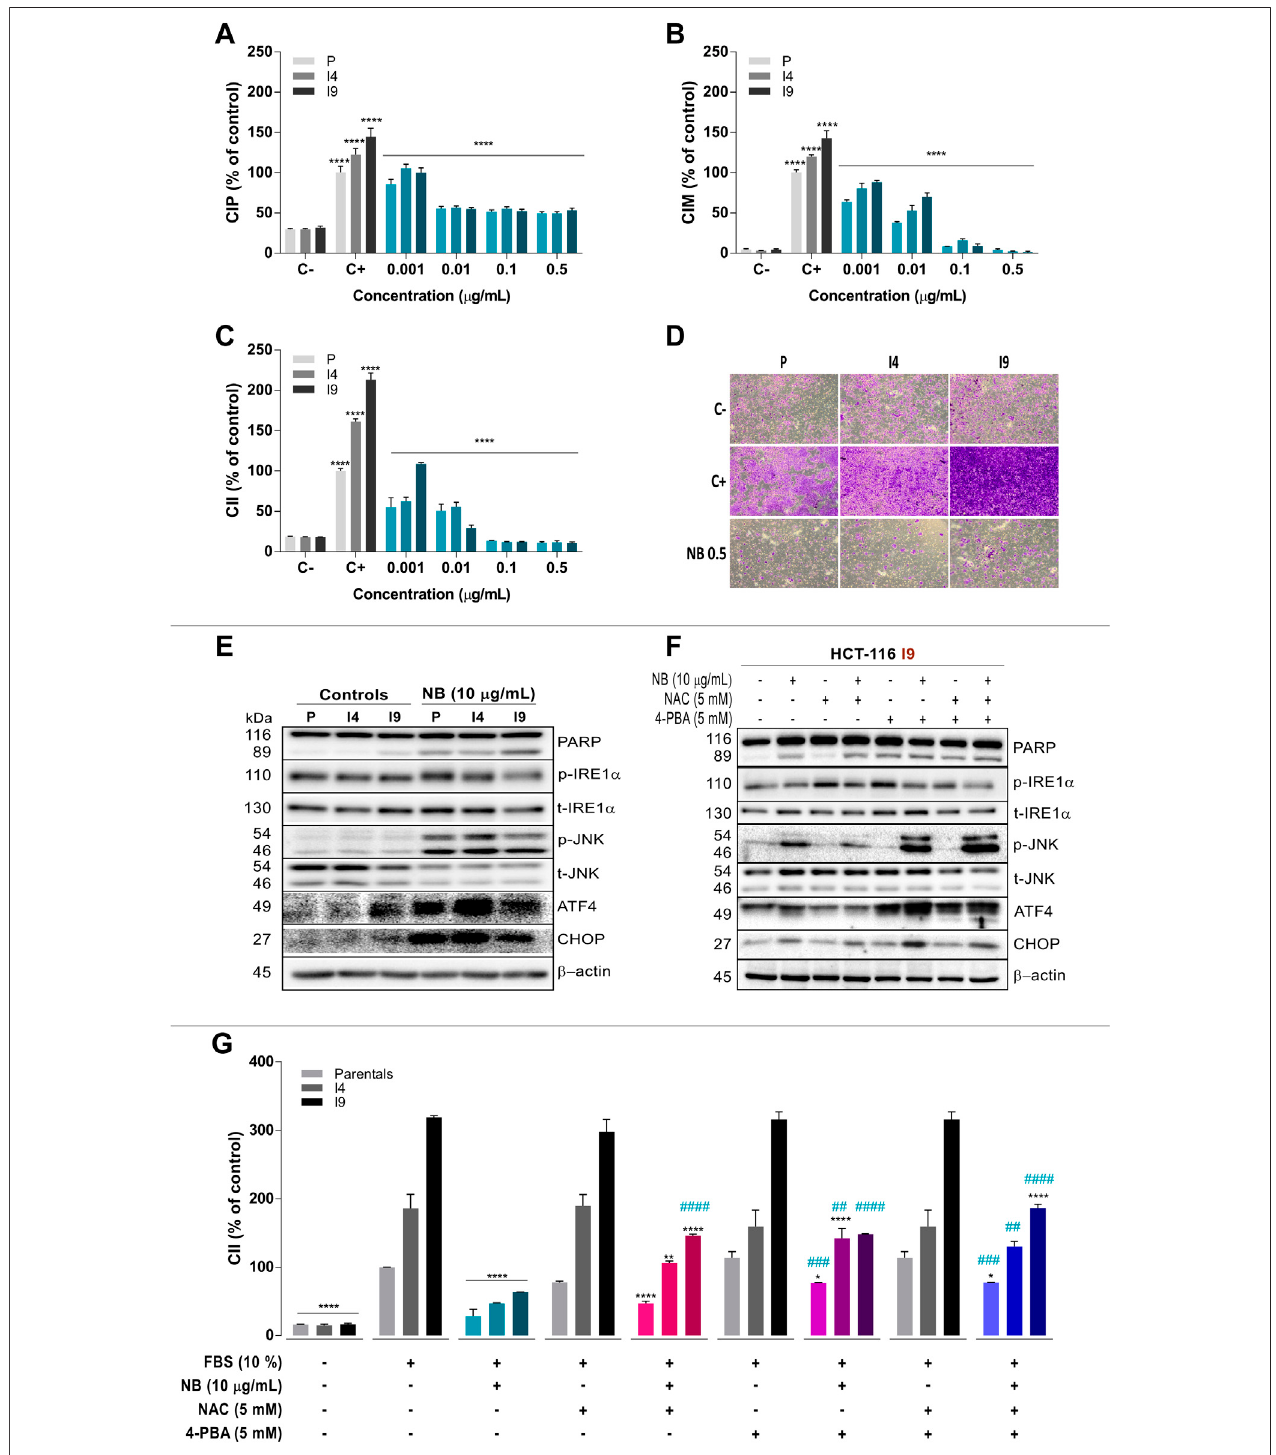
FIGURE 6 | Effect of NB on superinvasive populations of HCT-116 cell lines. The P, I4, and I9 cell lines were seeded on an E-Plate to assay the cell index of proliferation(CIP) (A) ,onaCIM-Platetoassaythecellindexofmigration(CIM) (B), andonaCIM-PlatecoatedwithMatrigeltoassaythecellindexofinvasion(CII) (C) ;the changes induced by NB treatment were measured. Data are presented as the mean ± SD of three independent experiments. Cell index data from the negative control (untreated cells in FBS-free media, C-) were compared to those from the positive controls (untreated cells cultured in media with 10% FBS, C+). The cell index of HCT-116 P, I4, and I9 cells treated with NB extract was compared to C+. Data are presented as the mean ± SD of three independent experiments. p -values were calculatedbycomparisonwiththeuntreatedcelllinecontrols(controlcellspluslessthan0.2%dimethylsulfoxide,(C)usingANOVA.* p -value < 0.05,** p -value < 0.01,*** p -value < 0.001, and **** p -value < 0.0001. D) Representative images (4X) of the P, I4, and I9 invasive populations stained with crystal violet in a transwell insert are shown. Untreated cells were used as a negative control (C-, 0% FBS, 0% invasion) and positive control (C+, 10% FBS, 100% invasion) and were compared to